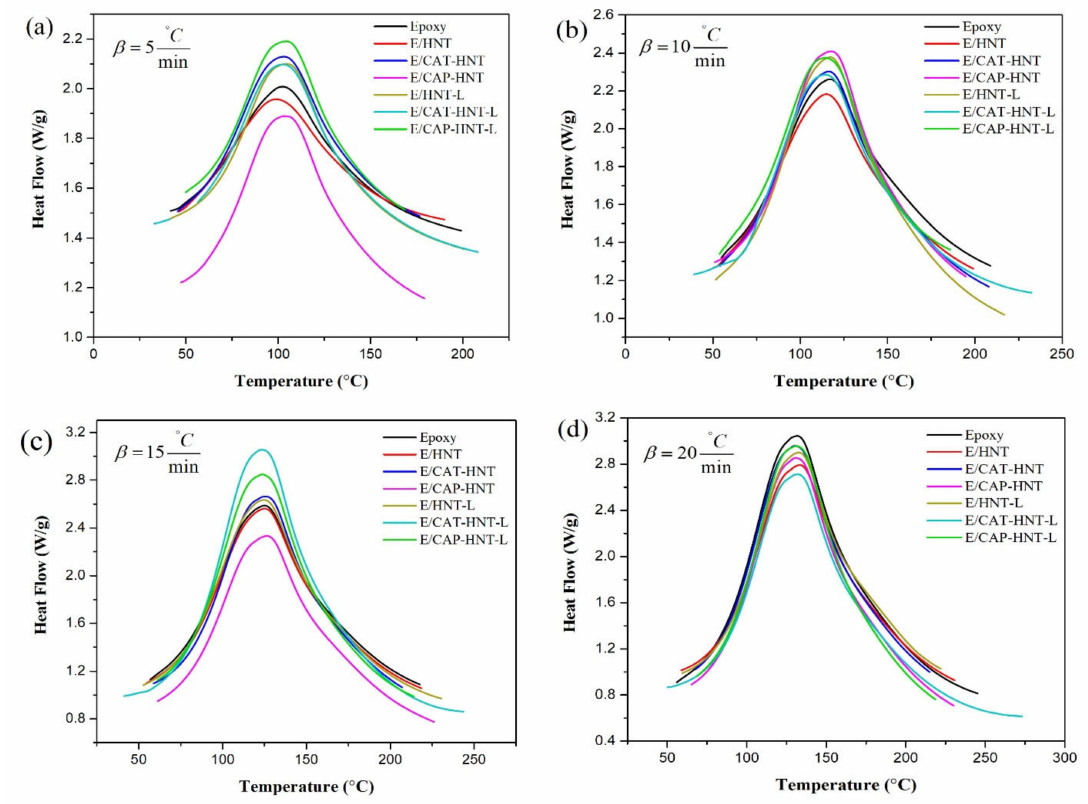
Figure 8. Nonisothermal DSC thermograms of epoxy and epoxy/HNT nanocomposites at heating rates of 5 ( a ), 10 ( b ), 15 ( c ), and 20 ( d ) ◦ C · min − 1